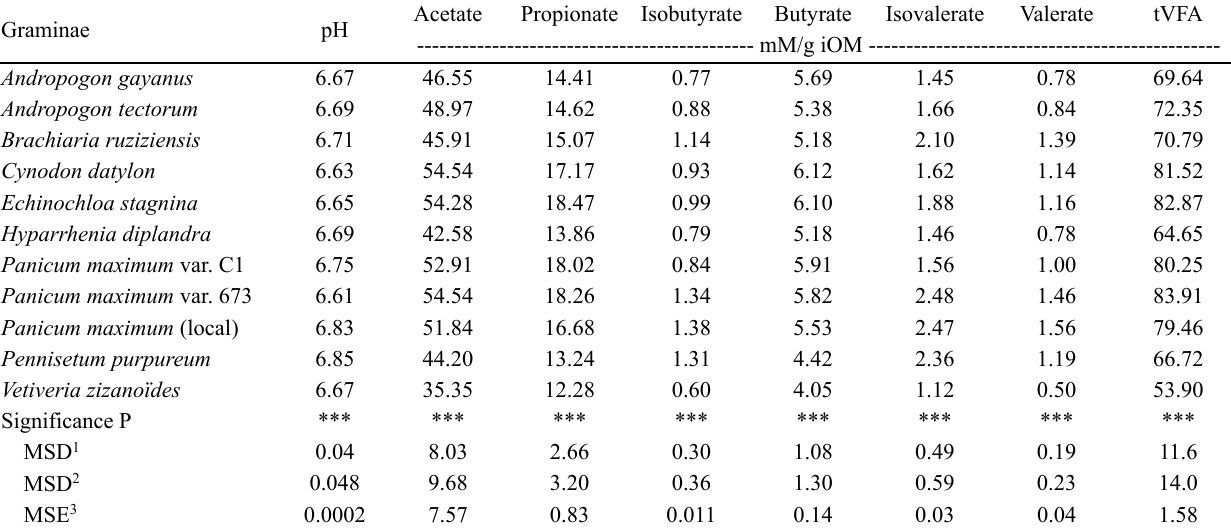
Table 5. Volatile fatty acids and pH at 120 h for grass Graminae